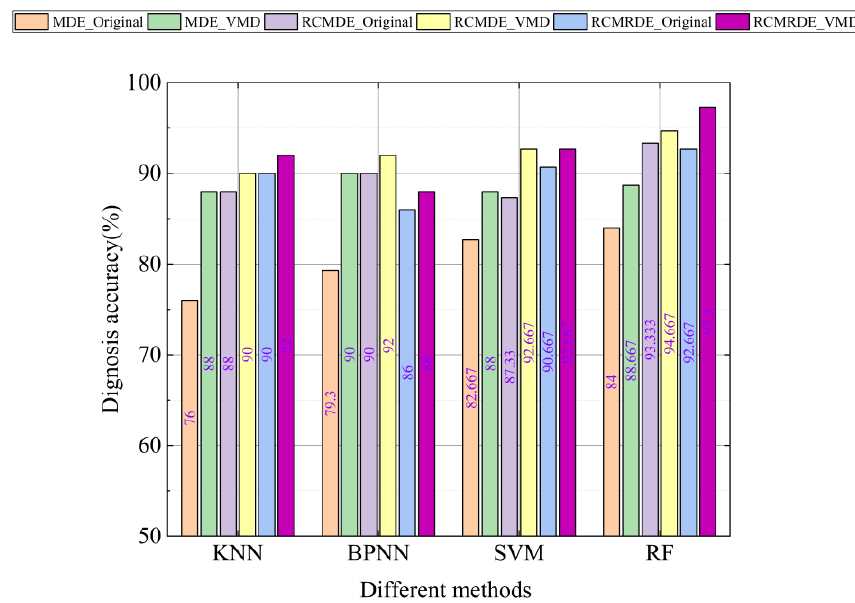
Figure 15. Comparison of diagnostic accuracy of different methods.